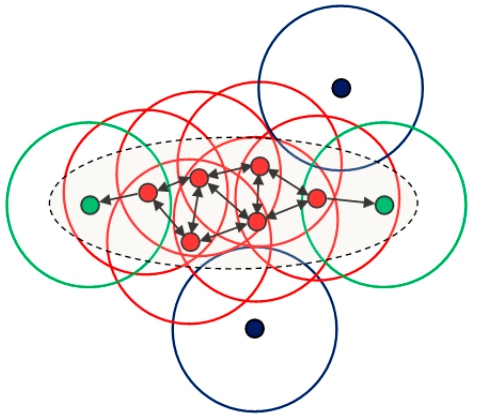
Figure 4. The schematic representation of the density-based spatial clustering of application with noise (DBSCAN) algorithm: the red points indicate the core points, the green points indicate the border points, the blue points indicate the outliers, and the gray ellipse indicates the cluster (core points and border points). The radius of the circle represents the distance threshold.